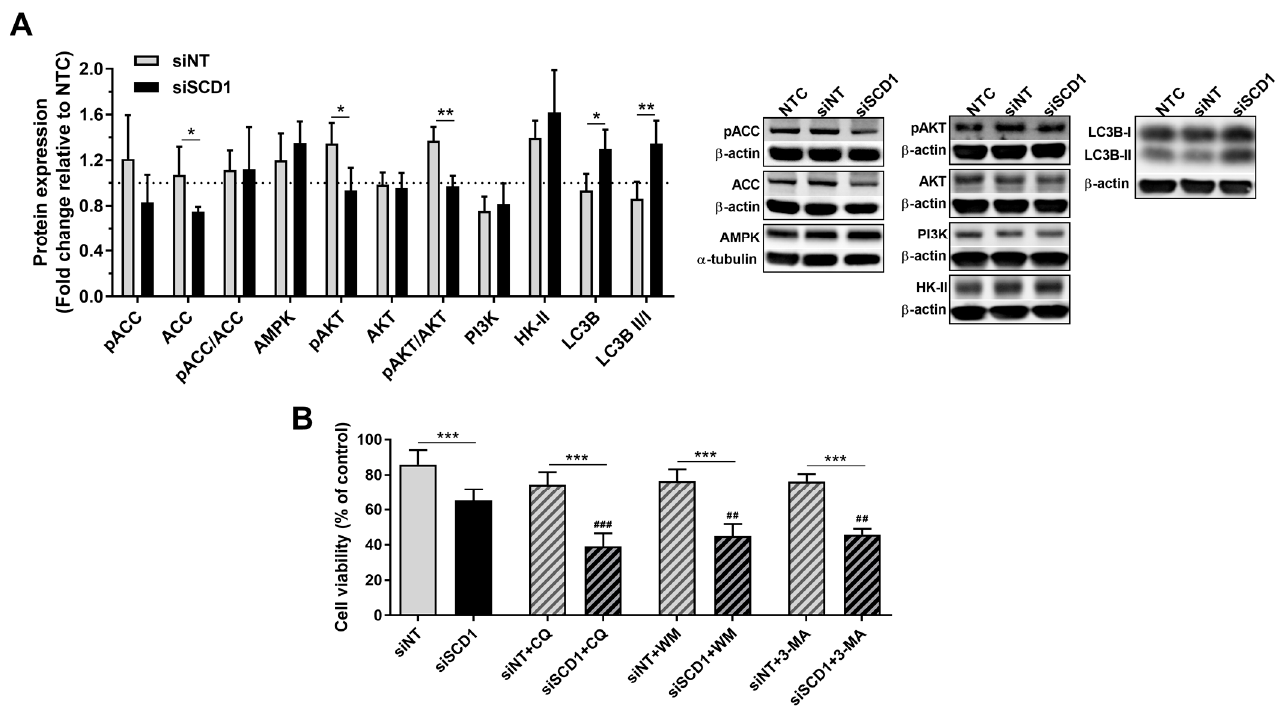
Figure 3. Effect of SCD1 silencing on the expression of proteins involved in the metabolism and autophagy of U87 cells and on cell viability in the presence of autophagy inhibitors. Cells grown in medium containing 2% FBS were transfected with an siRNA against SCD1 (siSCD1) or a non-targeting siRNA sequence (siNT), complexed with Lipofectamine RNAiMAX. ( A ) Sixty-eight hours after transfection, the levels of SCD1, pACC, ACC, pAKT, AKT, PI3K, HK-II and LC3B were evaluated by Western blot analysis and normalized to non-treated cells (NTC) ( n = 3–6; unpaired two-sided t-test; * p < 0.05, ** p < 0.01, *** p < 0.001); the pACC/ACC and pAKT/AKT ratios were determined from the corresponding levels of the pairs pACC and ACC, and pAKT and AKT, respectively. The LC3B II/I ratio was determined from the corresponding expression levels of LC3B II and LCB3I. ( B ) Twenty hours after transfection, chloroquine (CQ), wortmannin (WM) or 3-methyladenine (3-MA) were added to U87 cells. Cell viability was evaluated 48 h later by the Alamar blue assay. Results are expressed as the percentage of the viability of NTC ( n = 4–6; one-way ANOVA followed by Tukey’s test; *** p < 0.001 vs. the respective siNT; ## p < 0.01, ### p < 0.001 vs. siSCD1 per se; siNT per se vs. siNT + autophagy inhibitors was not significant).